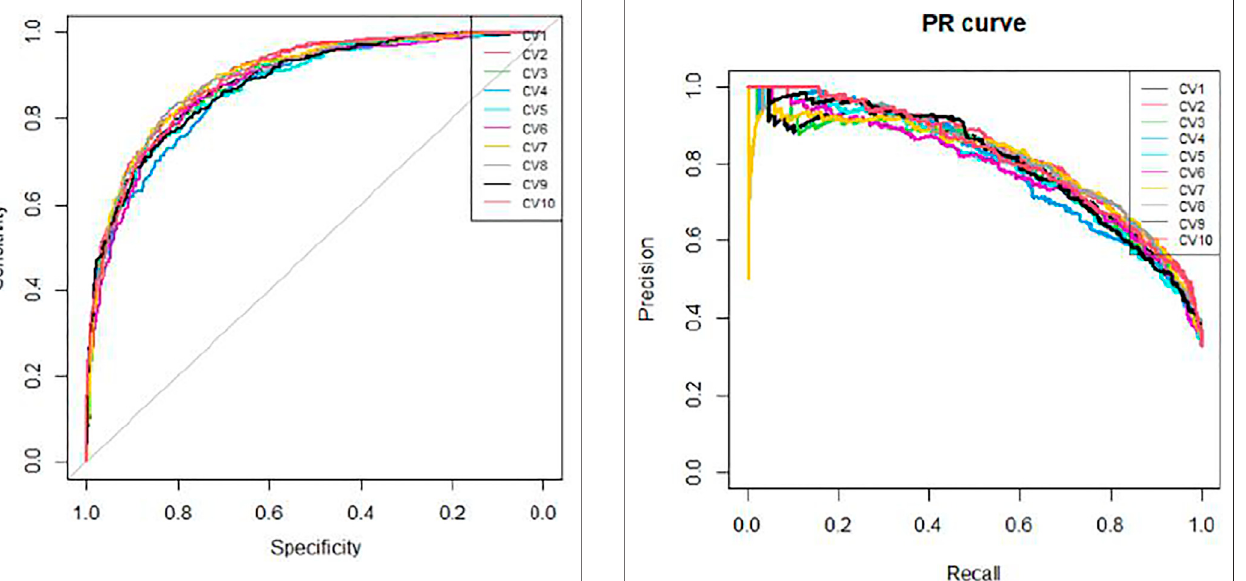
FIGURE 2 | PR curves of 10-cross